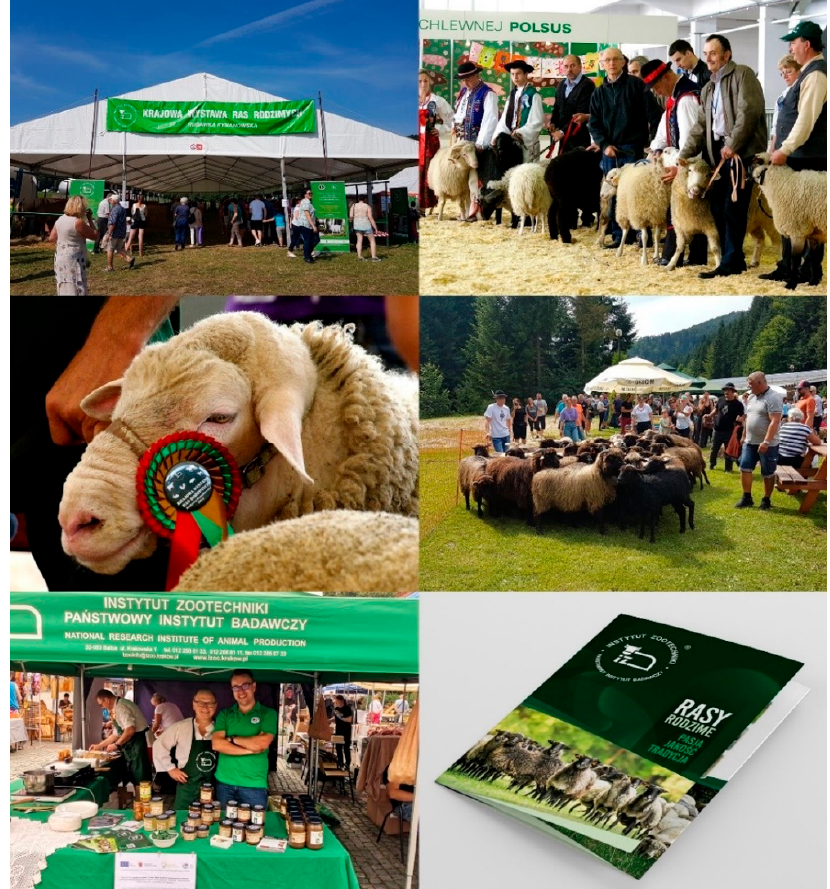
Figure 7. Exhibitions of native breeds organised by NRIAP and NRIAP promotional materials.